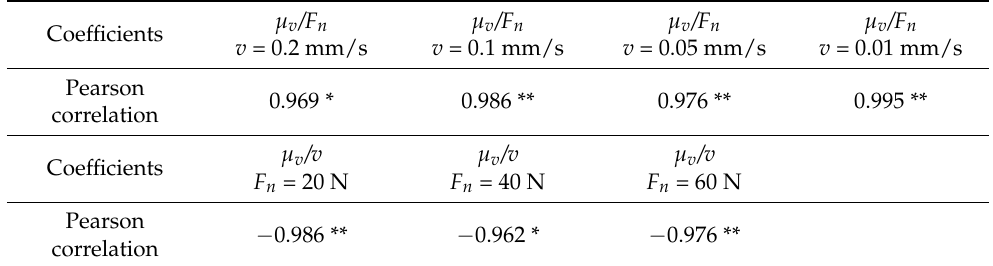
Table 2. Correlation between SS amplitude and normal force, respectively, and driving speed.